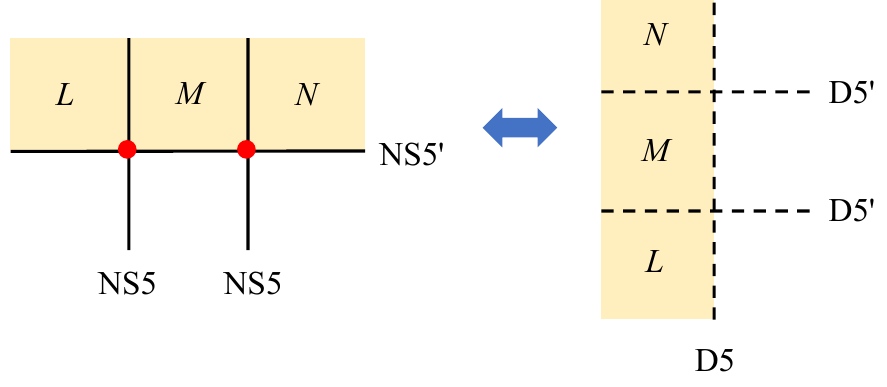
3d U( M ) 4d U( N ) with Neumann | |